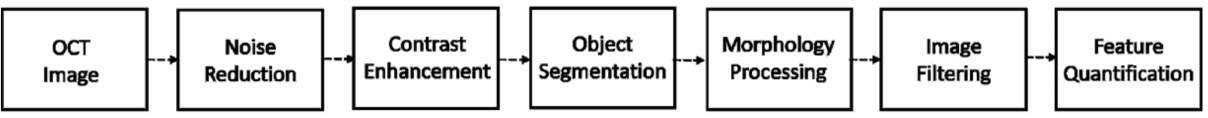
Figure 1. Block diagram of the proposed computer-aided detection (CADe)